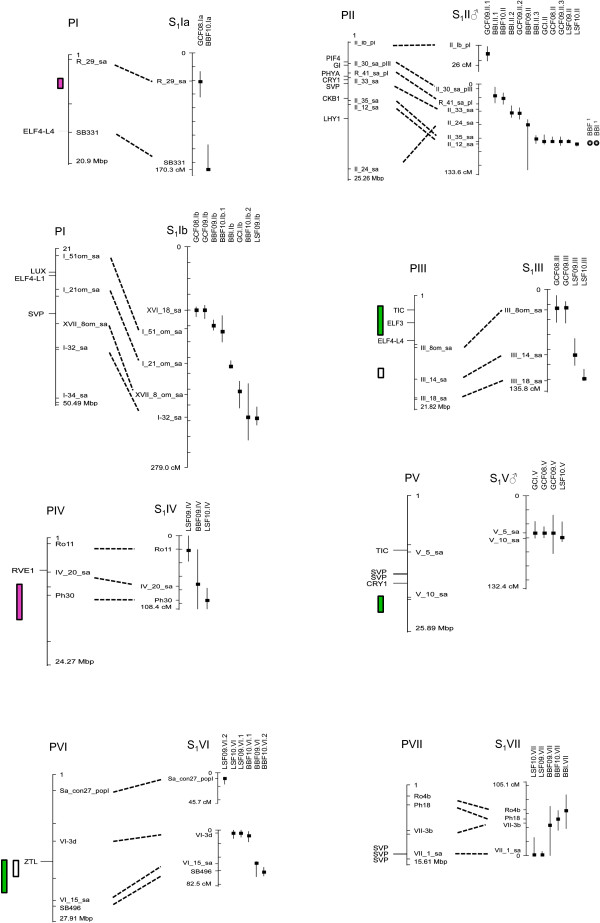
Location of spring and autumn phenology QTLs on the consensus genetic linkage map from the S1 pedigree on LG I to VII. The peak position of the local LOD (P in Table 4) is marked as a squared symbol and a support interval of 1.5-unit drop off on either side of the LOD peak is reported for each QTL. QTLs are named as in Table 4. Candidate genes and their position in the corresponding Populus chromosome are indicated. Grey circles on LG II: Bud burst QTLs in field (BBF) and indoor (BBI) conditions from [42] (same mapping pedigree, tentative positions based on common AFLPs). QTLs for phenology traits in Populus (taken from literature) are indicated. Red boxes: Selected QTLs associated with bud set (several stages and sub-processes) in Populus nigra from Table six in [50]. White boxes: Bud set or bud flush QTLs from [48] at tentative positions, based on their distance from a SSR marker (Chr III) or phenology candidate genes (Chr VI) in the original publication (as in [18]) Green boxes: Bud set robust quantitative trait loci (QTL) regions in [18].